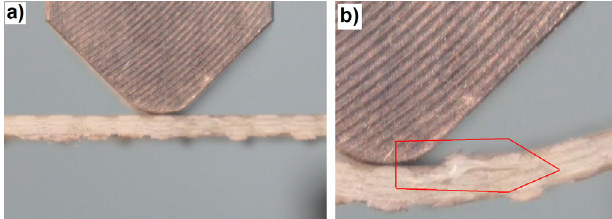
Figure 9. Photograph showing the main failure in the 3D laminate, direction W : ( a ) Beginning of the bending test; ( b ) 60 s of the test, right after the occurrence of the main failure.